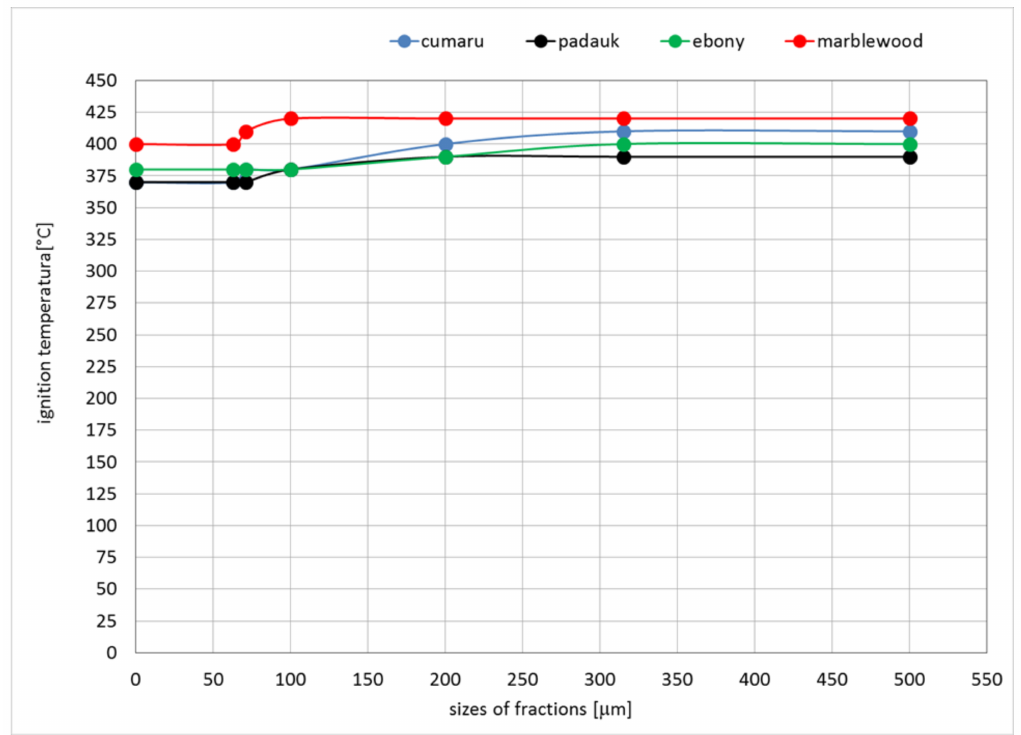
Figure 9. Ascertaining of the ignition temperature fractions of the tropical wood